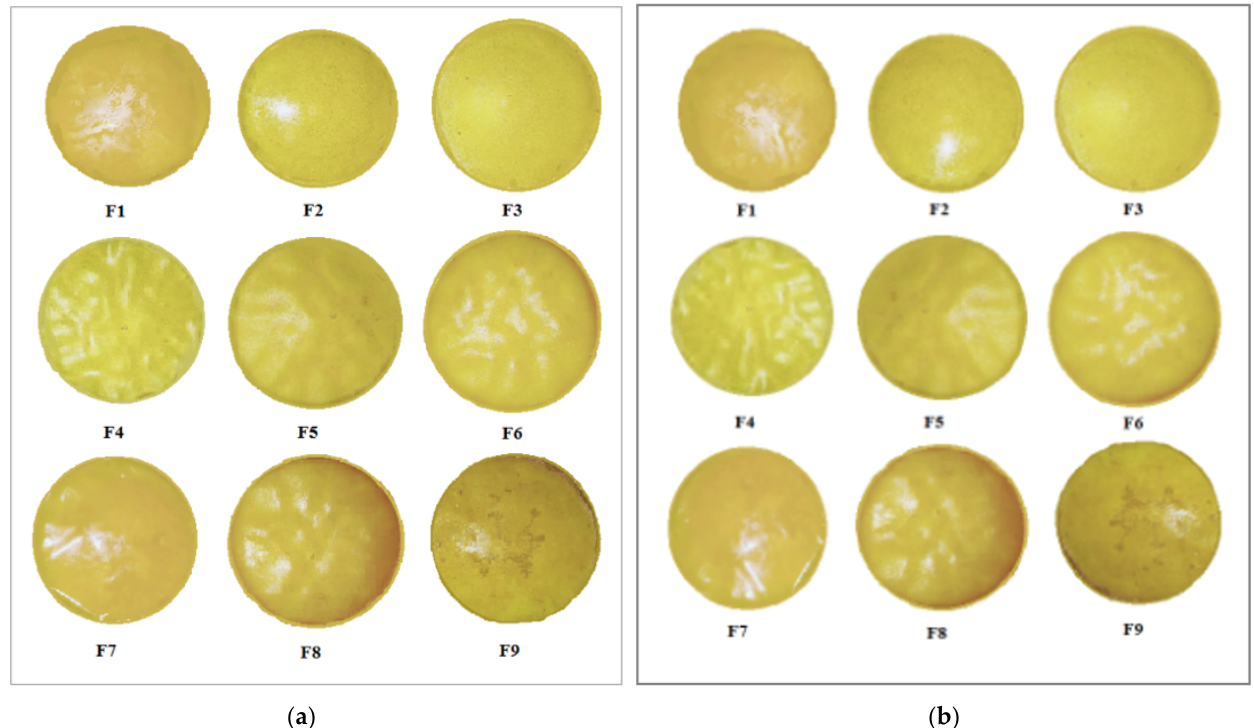
Figure 2. Physical appearance of formulated (F1–F9) patches shown at Day 1 ( a ) and after 180 days ( b ). Table 4. Results of skin irritation on rabbits. Data were expressed as mean ± SD, n = 3. Significant compared to formalin ( p <